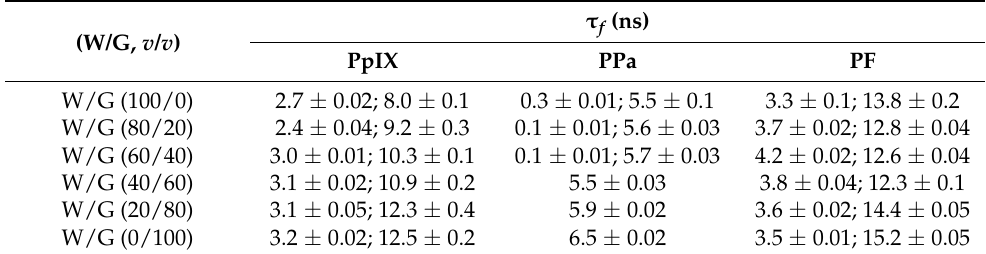
Table 7. Fluorescence lifetimes of PpIX, PPa, and PF ( λ exc = 408 nm, c = 3.1 μ M) at room tempera- ture.